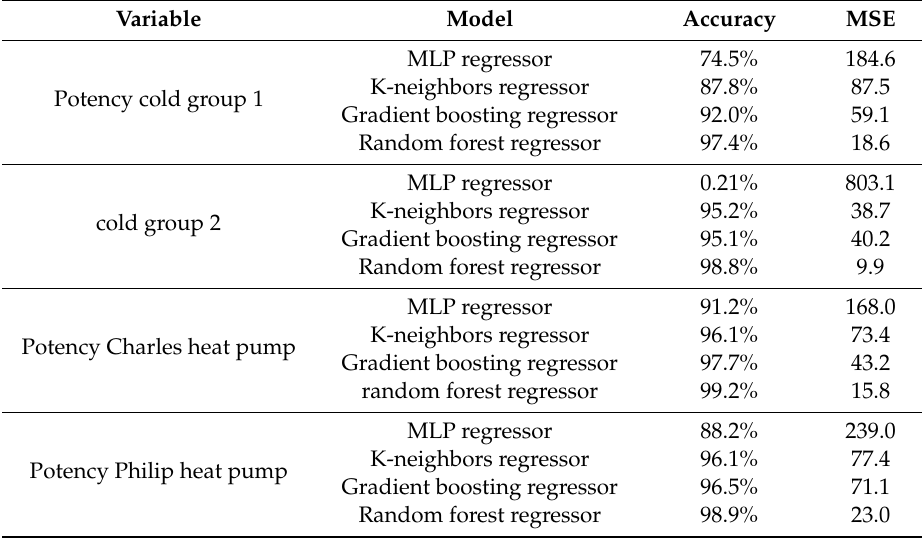
Table 8. Quality of the data model algorithms used to predict the variable